Question: Sum up the contents of this chart in one sentence.
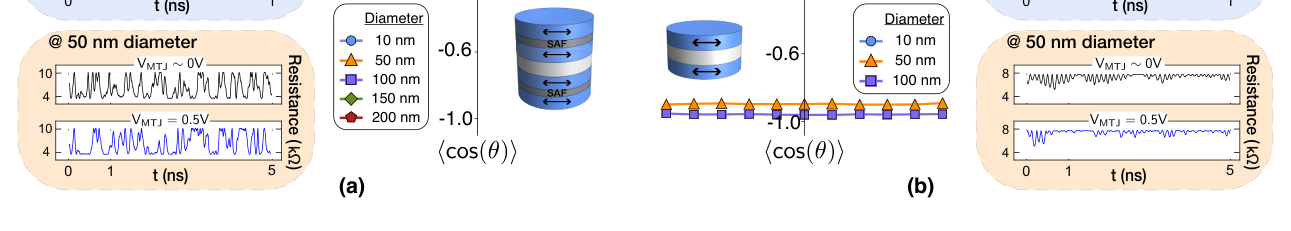
Answer: Bias dependence of sMTJs (a) Shows the time-averaged cos θ as a function of the bias voltage across the MTJs for the double-SAF-free sMTJ. Left-hand side shows corresponding resistance fluctuations at chosen diameters of 10-50 nm and bias points of 1 mV - 0.5 V. The fluctuation rates are inversely proportional to device diameter, Φ, as predicted by Eq. 9. Device exhibits independence between the free layers, ⟨cos θ⟩≈0, with bias-independence. (b) Shows the time-averaged cos θ as a function of the bias voltage for a double-free sMTJ, modeled as two F|N interfaces in series. Right-hand side shows corresponding resistance fluctuations at chosen diameters of 10-50 nm and bias points of 1 mV - 0.5 V. These results are in quantitative agreement with the phenomenological model introduced in Ref. [39]. Unlike that model however we do not legislate antisymmetric currents to the magnets at the interfaces. This behavior comes out of our fine-grained interface model. Moreover, due to the u